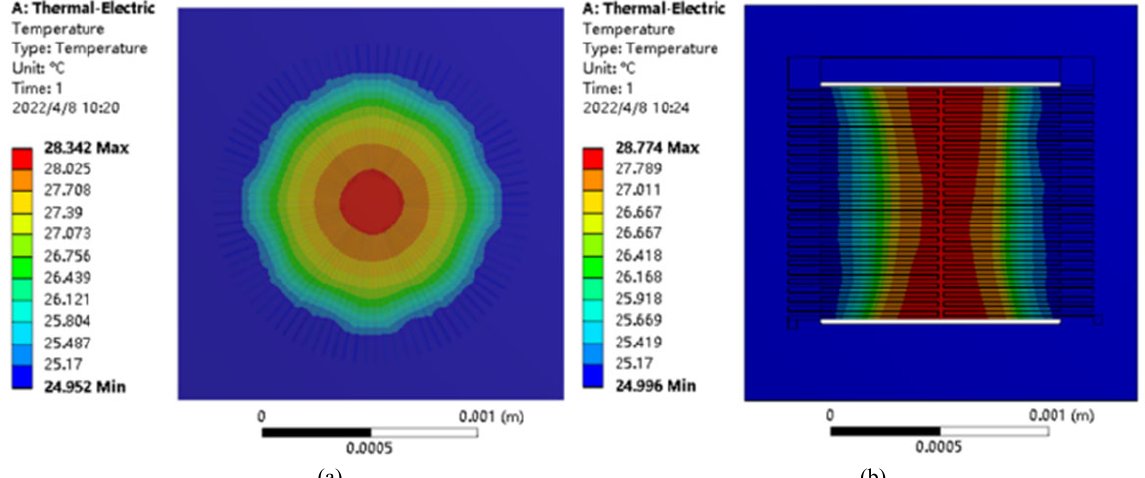
Fig. 2 Temperature distribution clouds for two structures of thermopiles: (a) circular thermopile temperature distribution clouds and (b) rectangular double-ended thermopile temperature distribution clouds.